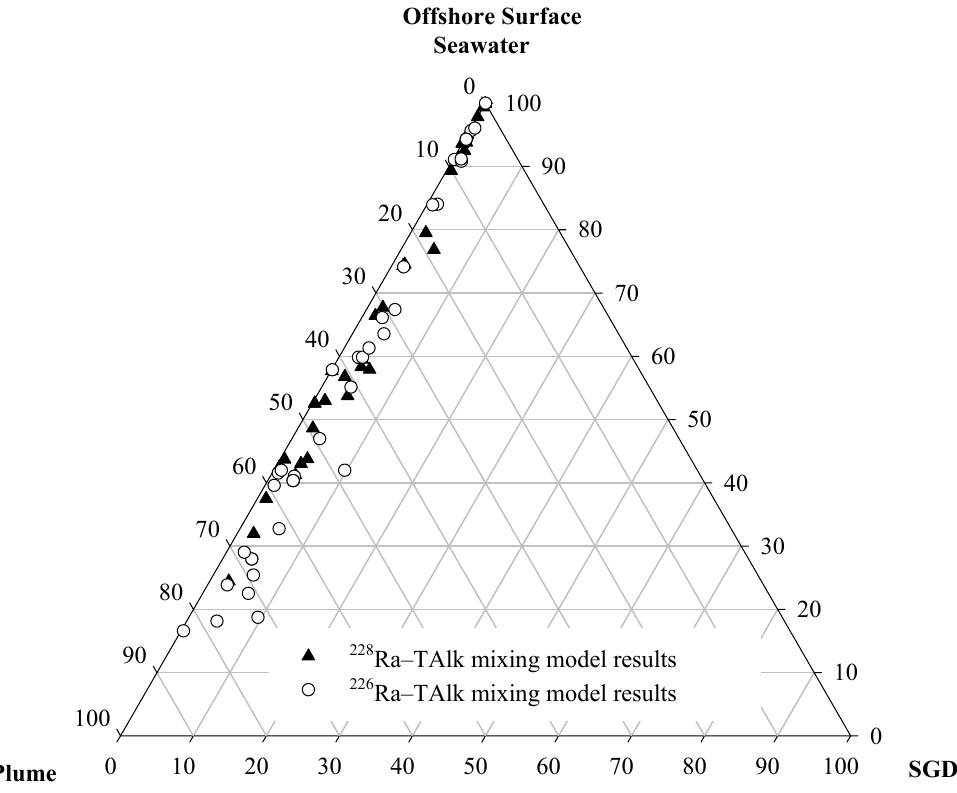
Fig. 8. Ternary diagram illustrating simulated percentage contributions from submarine groundwater discharge (SGD), offshore surface water, and Pearl River plume for surface water of the northern South China Sea for the period 30 June–8 July, 2008 using a three end-member mixing model based on 228 Ra and total alkalinity (TAlk), and 226 Ra-TAlk. Table 3. Submarine groundwater discharge (SGD) estimated based on a three end-member mixing model and Ra mass balance in the northern South China Sea. Also shown are the sensitivity analysis and error sources with different methods.